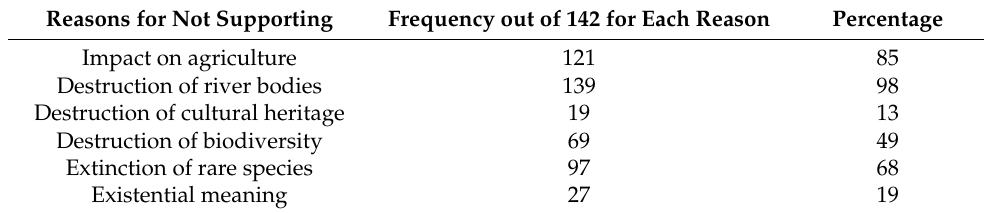
Table 6. Reasons for not supporting the proposed mining of the forest reserve. Reasons for Not Supporting Frequency out of 142 for Each Reason Percentage Impact on agriculture 121 85 Destruction of river bodies 139 Destruction of cultural heritage Destruction of